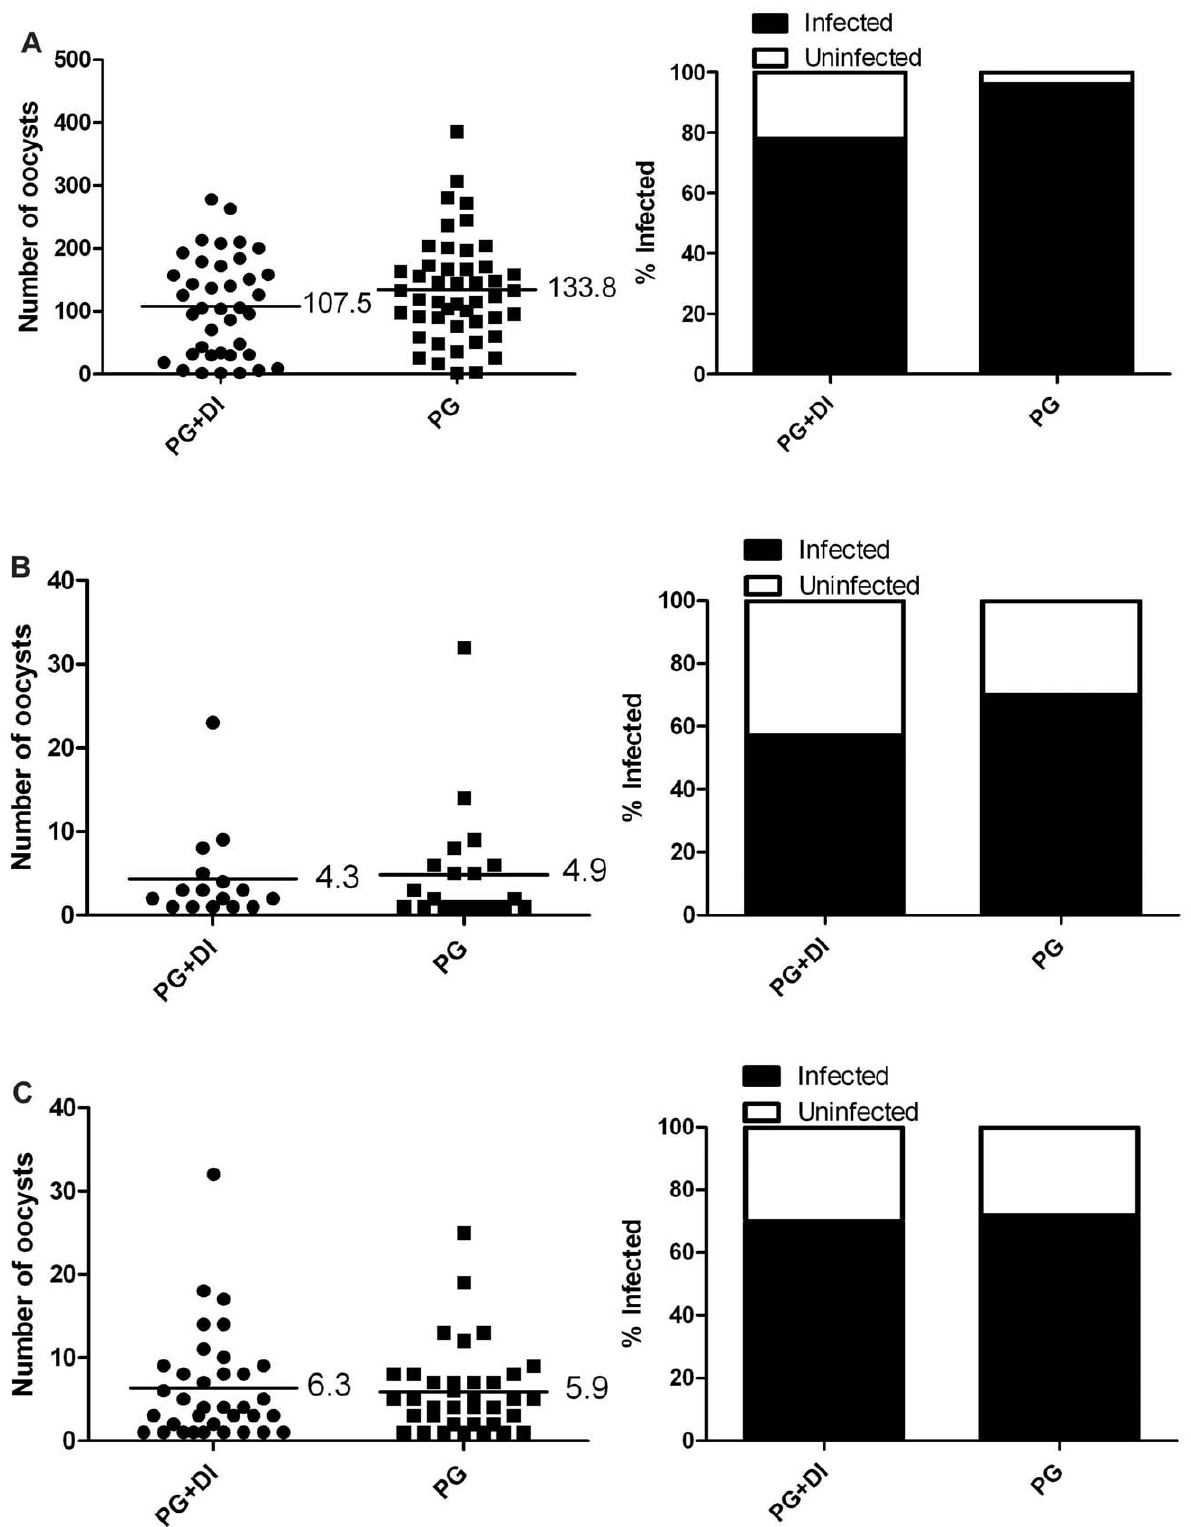
Figure 5. Plasmodium infection in Ar.subalbatus that concurrently ingested P.gallinaceum and D.immitis. Mosquitoes that fed on blood containing P. gallinaceum alone served as controls. For all, the left panel indicates infection intensity where points indicate the absolute value of oocyst counts in individual mosquitoes, and horizontal black bars represent the mean intensity. The right panel indicates prevalence of infection where the bars represent the total population of mosquitoes examined. The filled portion of the bars indicates the proportion of mosquito midguts that were positive for at least one oocyst; the unfilled portion of the bar indicates the proportion of midguts that were uninfected. There was no